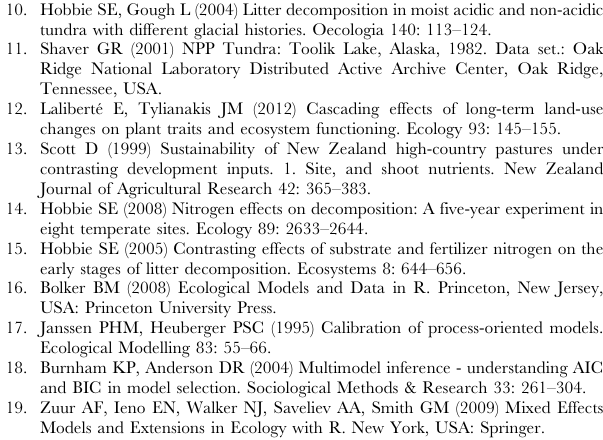
Figure S8 Average k value for simulations using beta error with normal error ( s = 0.05) added with k estimated by each regression technique (SV transformation). Table S1 Bias and D AIC c values for Hobbie [14] and Laliberte´ and Tylianakis [12] data where normal k estimates were greater than beta k